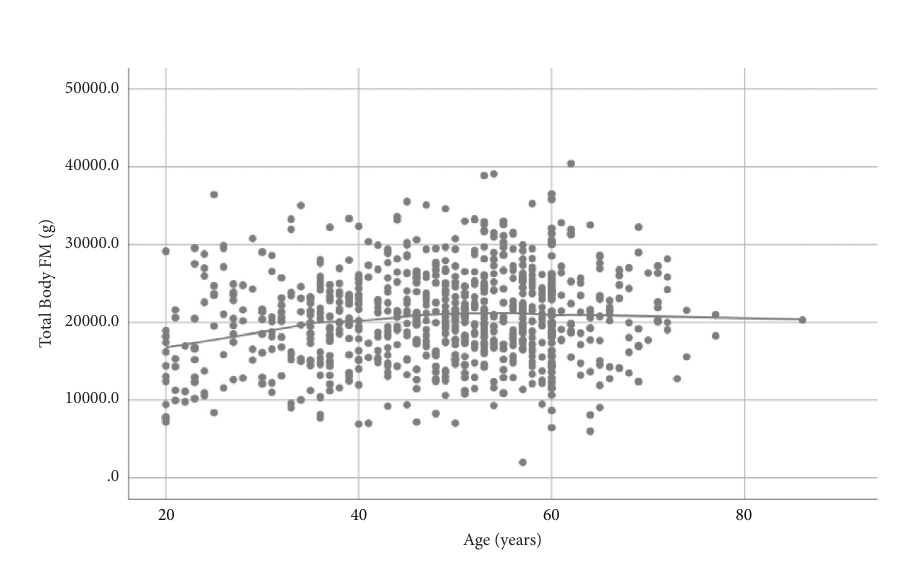
Figure 3: Age-related trend of